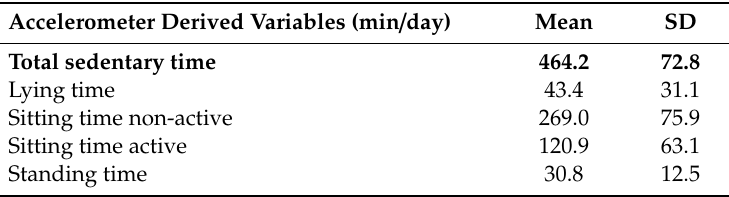
Table 3. Time spent in di ff erent types of sedentary behavior.